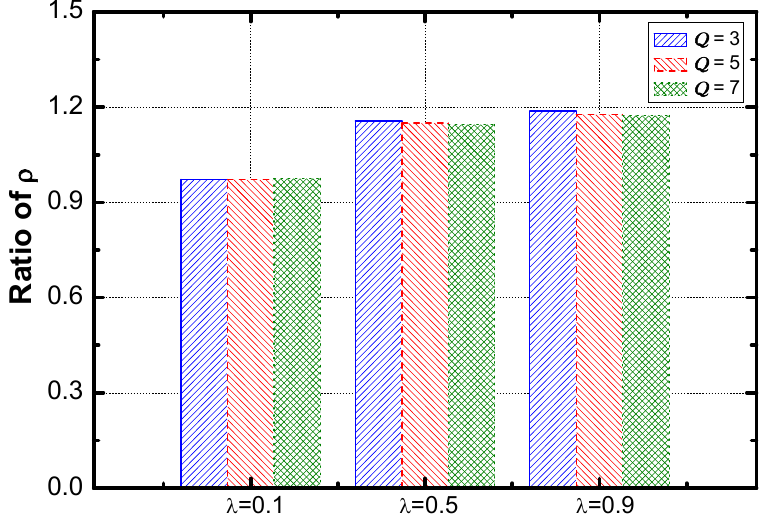
Figure 21. The ratio of service guarantee rate vs. λ .